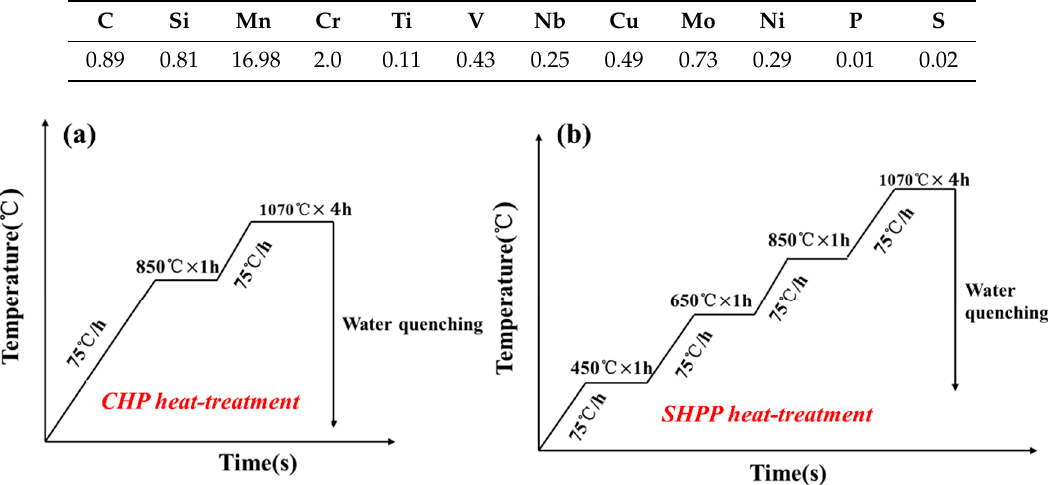
Table 1. Chemical compositions of experimental steel (wt.%).